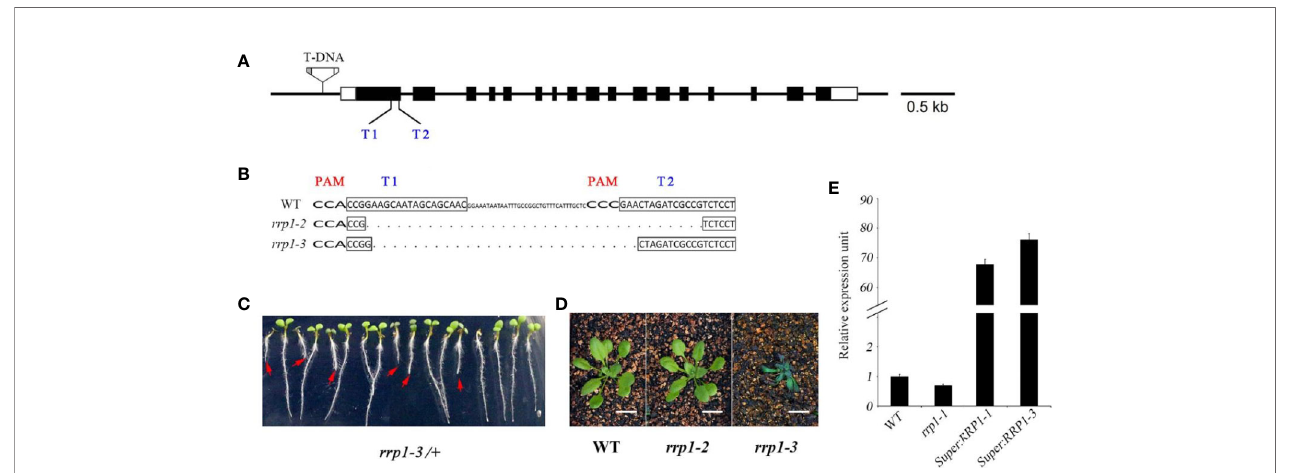
FIGURE 1 | Manipulation of Arabidopsis SCD2/RRP1 expression affects Arabidopsis seedling growth. (A) Schematic illustration of RRP1 genomic regions with the rrp1-1 T-DNA insertion and CRISPR/Cas9 targets. Empty boxes represent 5 ′ and 3 ′ untranslated regions, black boxes represent exons, and black lines represent introns. T1 and T2 represent two target sites for CRISPR/Cas9 editing. The T-DNA insertion is not drawn to scale. Bar = 0.5 kb. (B) Homozygous rrp1 mutants of the T 3 generation were generated by CRISPR/Cas9 editing. Mutation of RRP1 was evaluated by sequencing. The protospacer adjacent motifs are marked with wide bold letters, the black boxes indicate targets, and the dashed line indicates regions of deletion. (C) Heterozygous rrp1-3/+ mutants of the T 2 generation grown vertically on Murashige and Skoog medium supplemented with 3% sucrose. The red arrows indicate homozygotes. (D) Phenotypic comparison between rrp1-2 , rrp1-3 , and wild type (WT) plants 4 weeks after germination. (E) Transcripts of the rrp1-1 mutant and a RRP1 -overexpression line ( Super : RRP1-3 ) were tested by quantitative real-time PCR. The data represent the mean ± SE ( n =